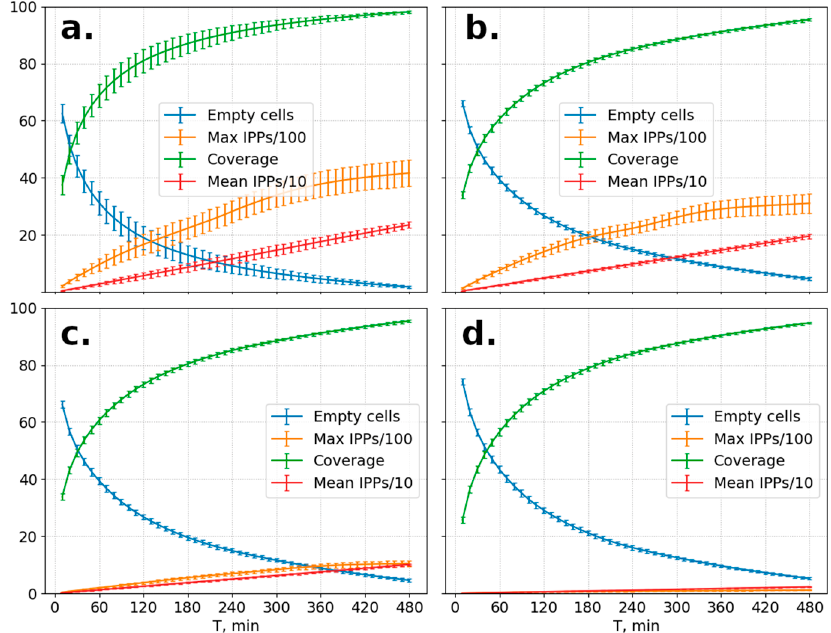
Figure 2. Percentage of filled (green) and empty cells (blue) and max/average (orange/red) amount of ROTI measurements used to calculate a single cell value versus duration of the averaging period. The calculation was performed on ( a ) all the available data and data with a spatial step of ( b ) 70 km, ( c ) 150 km, and ( d ) 700 km.